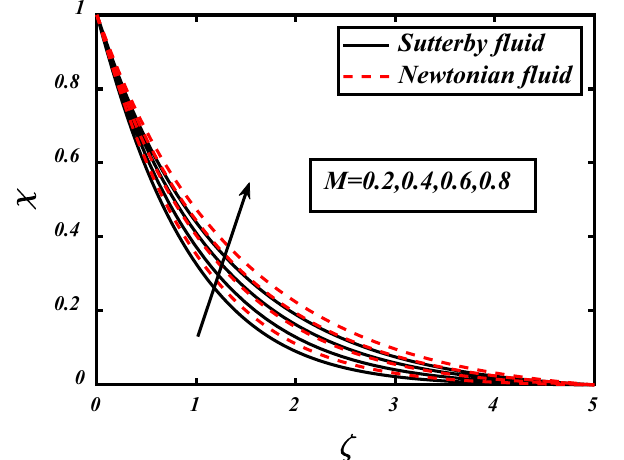
Figure 14. expounds the impacts of M on χ .